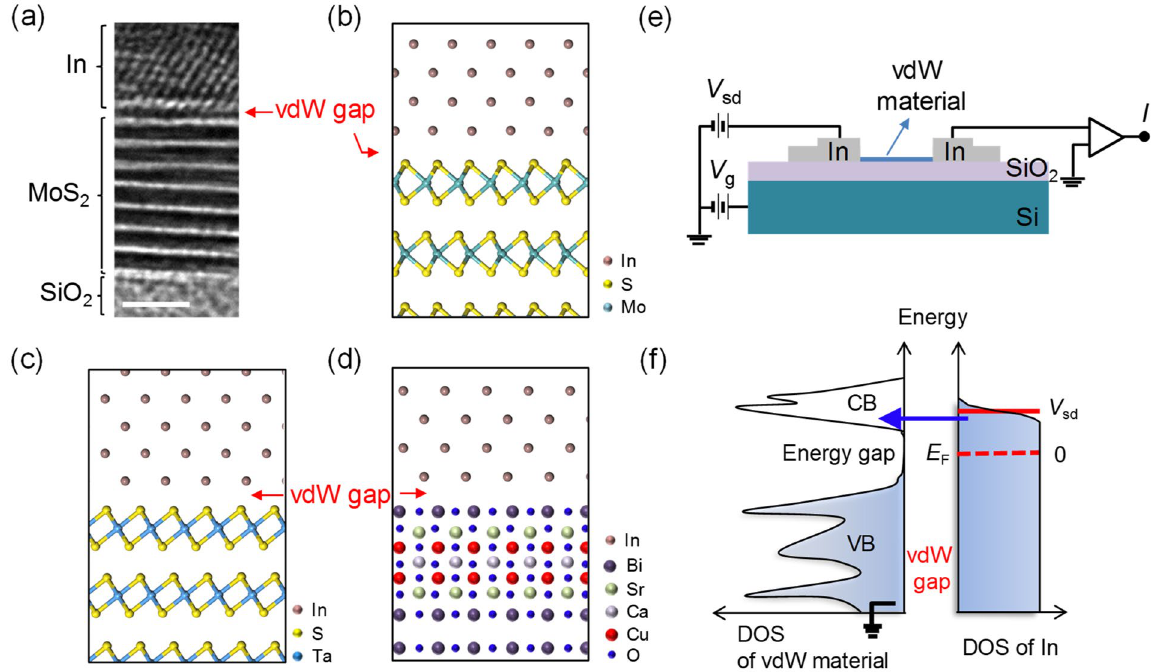
Figure 1. In-contacted vdW gap tunneling spectroscopy for vdW layered materials. ( a ) Cross-sectional TEM image of an In/few-layered MoS 2 junction. Scale bar: 2 nm. ( b )–( d ) Atomic structures at In/2 H -MoS 2 , In/1 T - TaS 2 , and In/Bi-2212 interfaces (schematic), respectively. Here, Atomic structures of In/2 H -MoS 2 and In/1 T - TaS 2 were prepared by the DFT calculations. ( e ) Schematic of the measurement configuration of a device with an FET design. ( f ) Schematic of the electronic DOS at a vdW material/In interface; this schematic describes the tunneling spectroscopy. CB and VB are the conduction and valence bands of MoS 2 , respectively. E F is the Fermi energy of the In electrode. Blue and white regions indicate states occupied and unoccupied by electrons, respectively. Under a zero-bias condition, the E F is located at the midgap in the energy-gap region of the vdW material (dashed red line). Under a bias voltage of V sd , the Fermi level of In becomes aligned with the empty states of the CB, resulting in a tunnel current through the vdW gap. The differential conductance obtained from the tunnel current at a cryogenic temperature reflects the DOS of the vdW